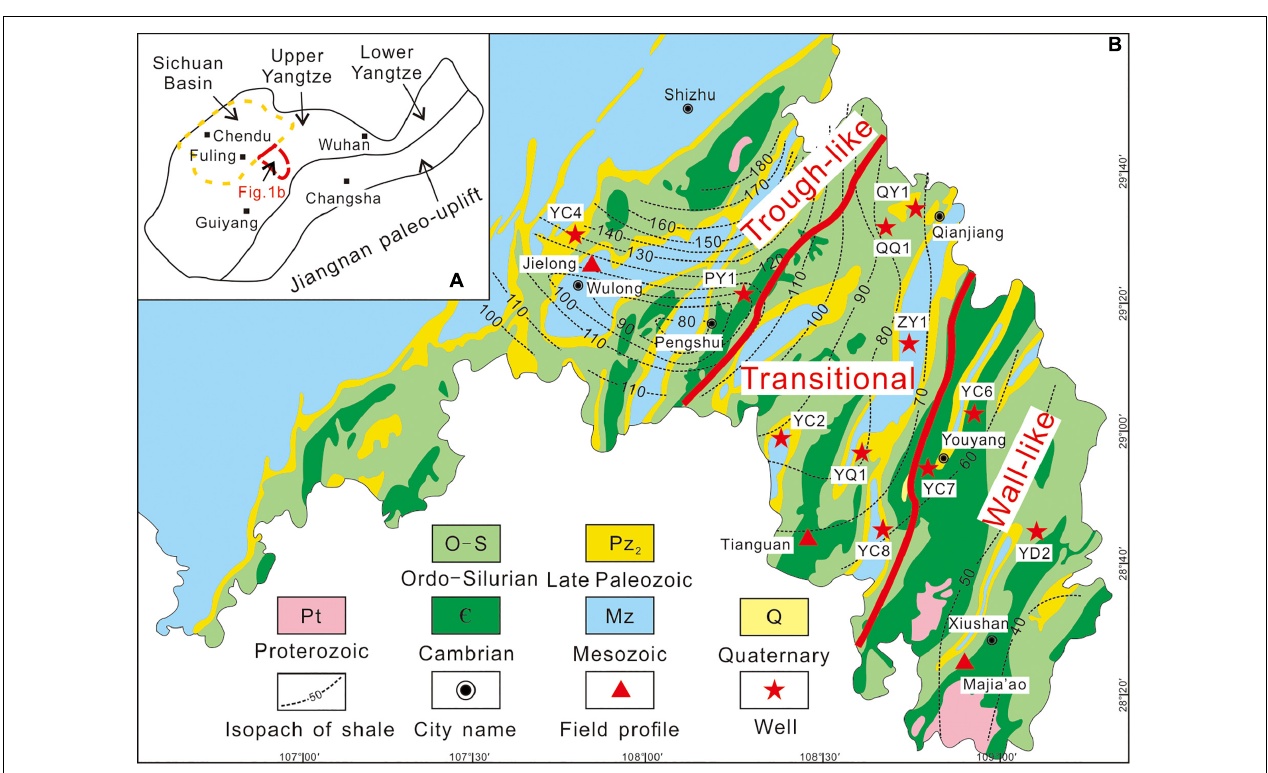
FIGURE 1 | (A) Map of the study area; (B) geological map of southeastern Chongqing and sampling points (refer to Wu et al., 2011; Tan et al., 2015; Luo et al.,